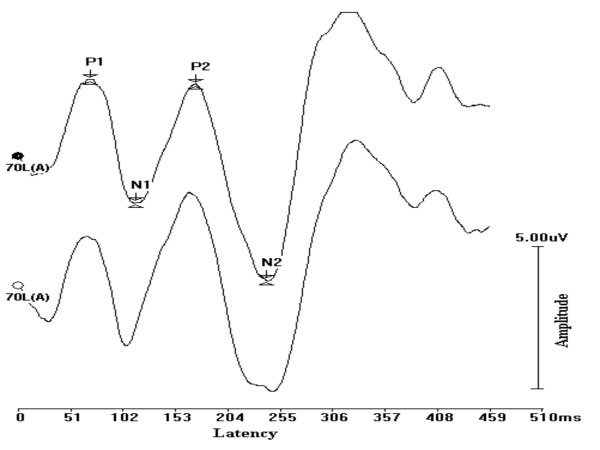
A representative late latency response recording depicting a good replicability.